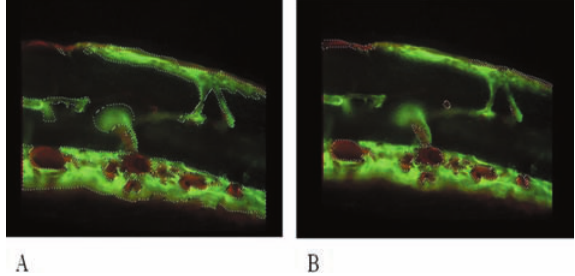
Figure 8- Calcein (A) and Alizarin (B) labeled areas delimited by dashed lines. (Imagelab